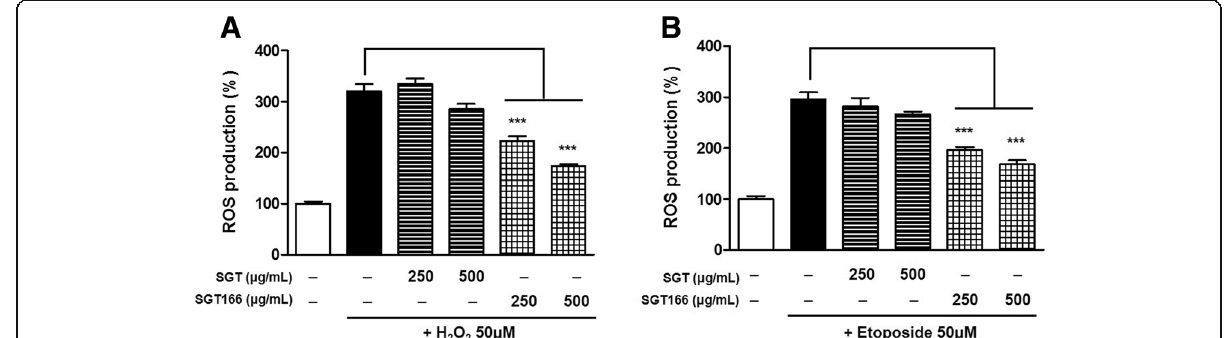
Fig. 5 The inhibitory effects of SGT and SGT166 against toxicant-induced ROS production in SH-SY5Y cells. Total ROS levels were measured using the H 2 -DCFDA method. Cells were pretreated with SGT or SGT166 for 6 h, and then labeled with 50 μ M H 2 -DCFDA for 30 min. Cells were separately exposed to 50 μ M H